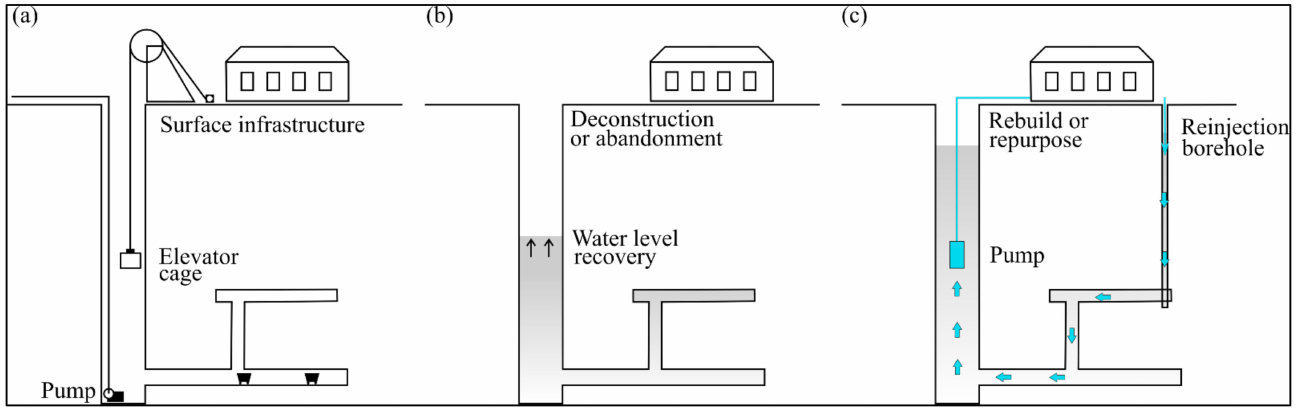
Figure 1. Schematic representation of the history of a mine, from ( a ) active mining with pumped dewatering; through ( b ) post-abandonment flooding; to ( c ) repurposed as a MWG